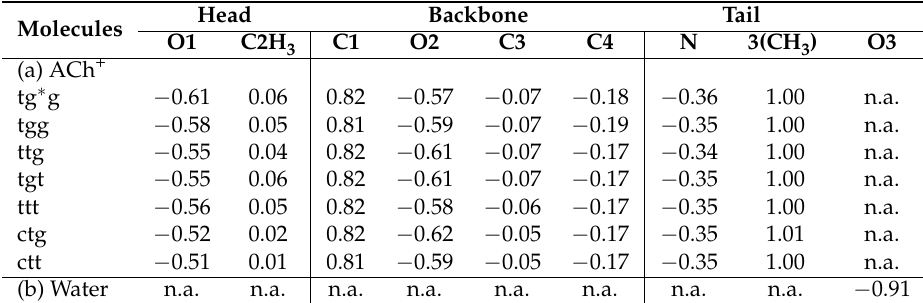
Table 5. The atomic charge populations (in unit e) of ACh + and water: Not available values are indicated by “n.a.”. Molecules